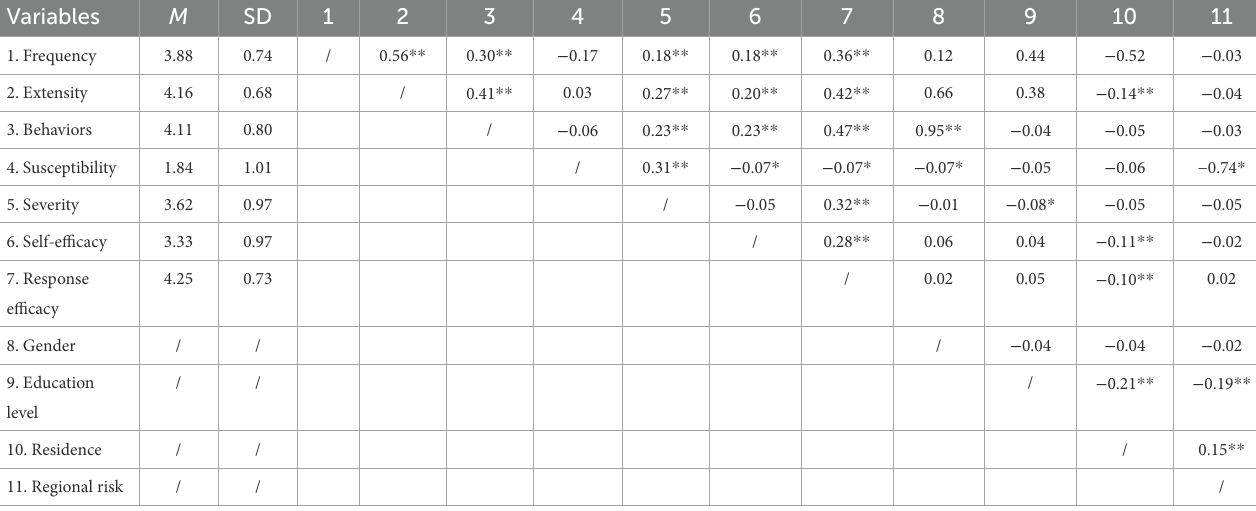
TABLE 2 Mean value, standard deviation and correlation coefficient of each variable. Variables